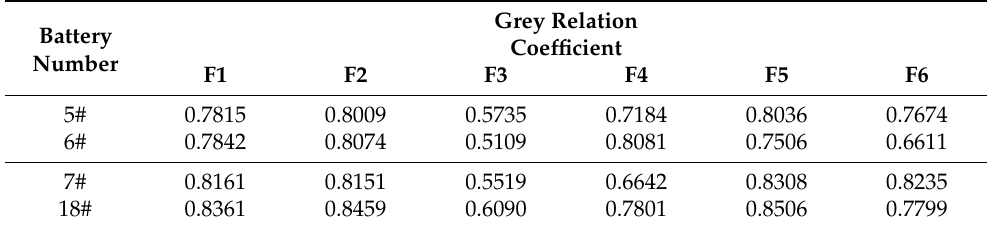
Table 2. Grey relation